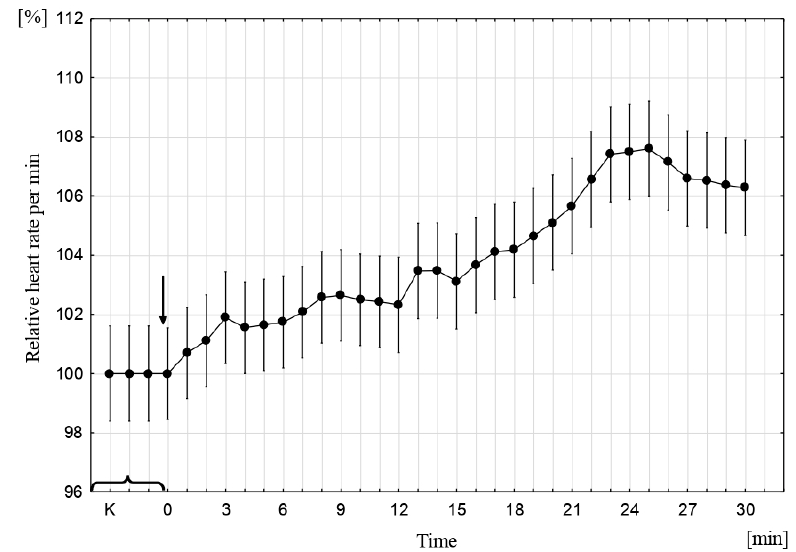
Figure 4. The relative number of cardiac contractions in sea trout embryos in alternating MF (15 mT, 50 Hz, p ˂ 0,001, vertical bars denote 95% CI); the number of contractions in the control was assumed to be 100%. K—control, 0—the point at which the MF was switched on [43]. In the European whitefish, as in the sea trout, the embryo’s heart in a time-varying MF (15 mT, 50 Hz, sinusoidal wave) accelerated, and a constant, steady increase was ob- served until the 22nd minute from the moment of exposure; the increased heart rate was maintained until the end of the experiment [43]. 2.6. Embryonic Pigment Cells Melanophores are star-shaped cells with numerous processes. Very important com- ponents of their structure are actin microfilaments and microtubules [46–48]. Melano- somes located in the melanophore cytoplasm are oval in shape and contain melanin, which protects the cell’s DNA against, e.g., ultraviolet radiation [49]. In embryonic devel- opment, in most cases, pigment cells become visible as early as 2 / 3 to ¾ of the course of embryogenesis, and the quantity of pigment contained in them increases gradually. Ini- tially, the greatest number of pigment cells occurs in the eyes, on the dorsal side of the embryo and in the yolk sac [50]. 2.6.1. Eye Pigment Constant exposure to an SMF from the moment of fertilization delayed the appear- ance of the pigment in European whitefish embryos, since melanophores in the eyes were visible from 92 D° in the embryos exposed in the fields of 1 and 3 mT and from 105 D° in those exposed in 5 mT, while in the control the first eye melanophores appeared after 86.5 D°. A similar delay in the appearance of eye melanophores was observed in the vendace: the first melanophores (in eyes) appeared in the control after 97.5 D°, and they appeared in an SMF of 1 mT after 11 D°, in 3 mT after 119.5 D°, and in 5 mT after 125 D° [51]. A similar dependence was observed in the African catfish ( Clarias gariepinus Burchel)) (Fig- ure 5).